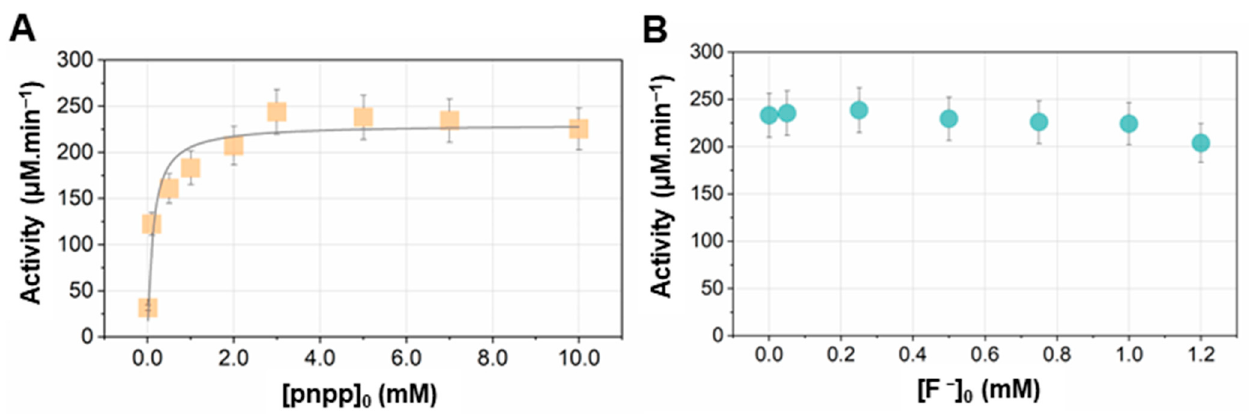
Figure 1. Evolution of the catalytic activity of ALP measured in Tris-HCl buffer solution (pH = 7.4; 37 °C) containing CaCl 2 (11.4 mM) as a function of ( A ) the initial pnpp concentration [pnpp] 0 or ( B ) the concentration of fluoride ions while [pnpp] 0 = 7.0 mM. Error bars depict experimental uncertainty, evaluated at 10%. Experimental data (symbols) are the average values measured over three replicates and fitted (straight line, panel A) using the classical Michaelis–Menten equation.